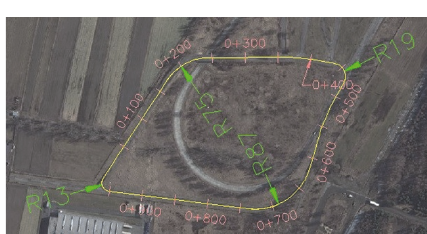
out on the experimental rides track of the Fiat Chrysler Automobiles Poland